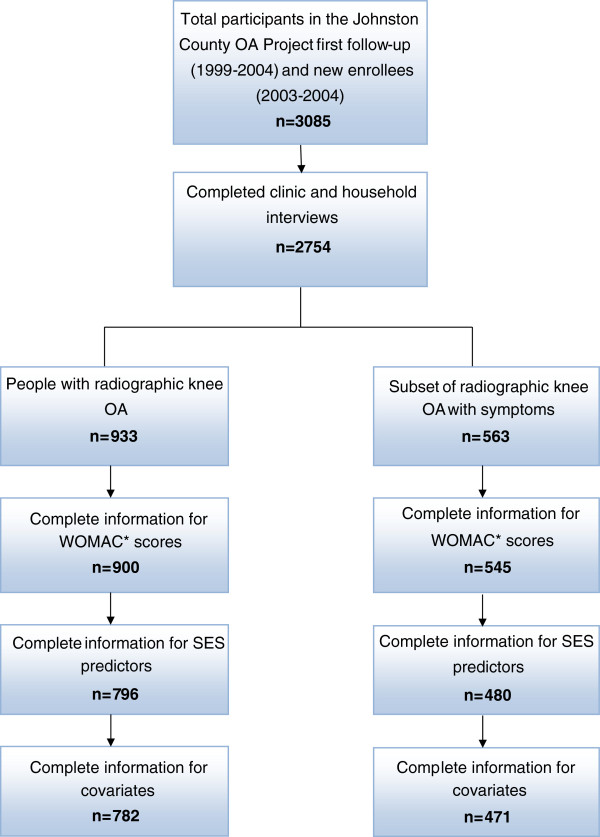
Participant flow chart. *WOMAC = Western Ontario and McMasters Universities Index of Osteoarthritis.